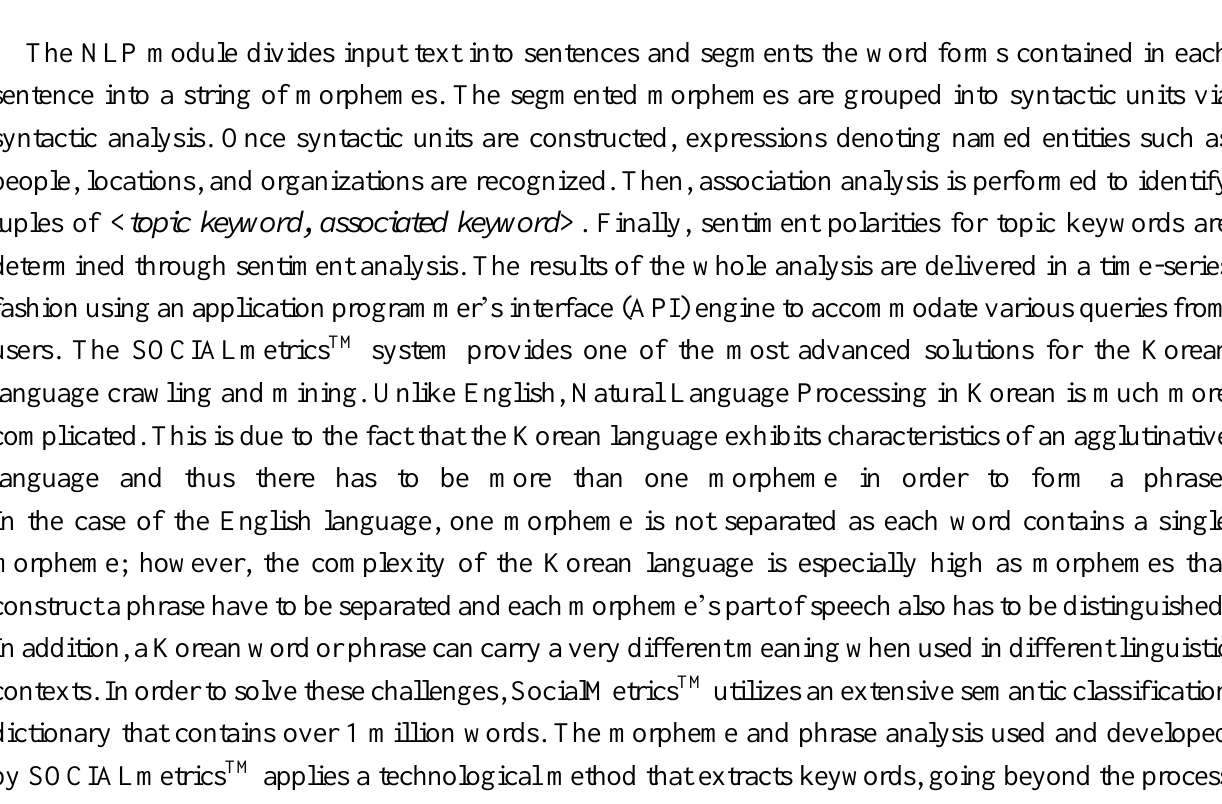
Figure 1. Overall structure of the SOCIALmetrics™ Social Big Data Mining